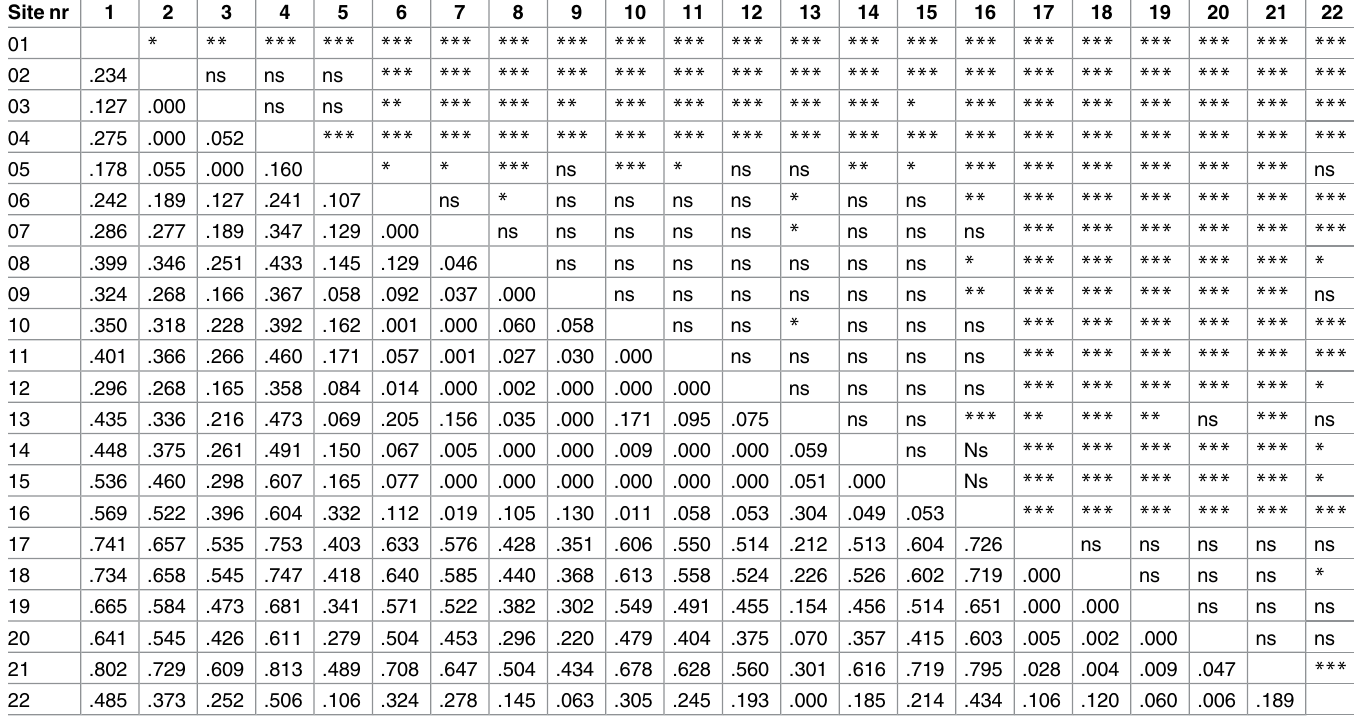
Table 1. Pairwise genetic differences in concatenated fragment of mtDNA CR and cyto b between samples of Ixodes ricinus from different loca- tions in northwest